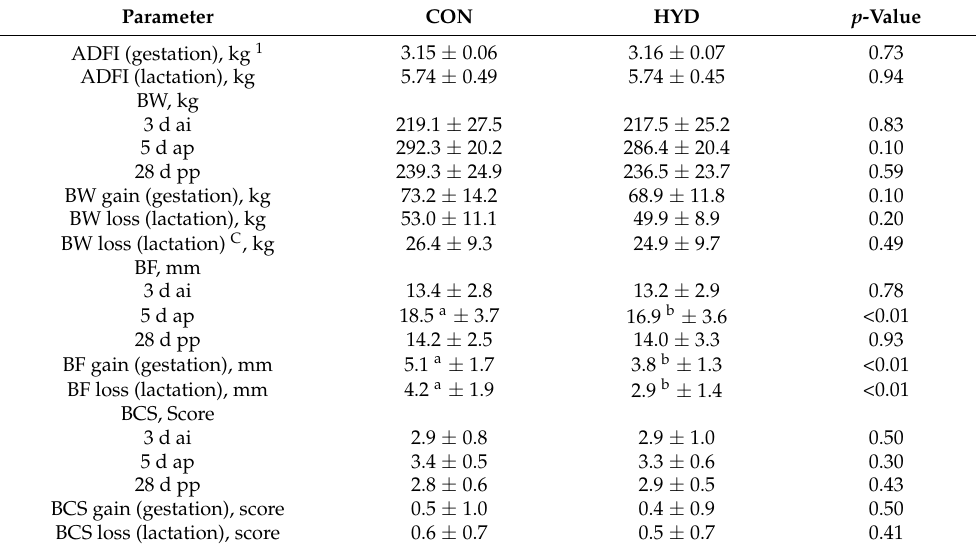
Table 5. Effect of dietary vitamin D source on condition development of sows (mean ±